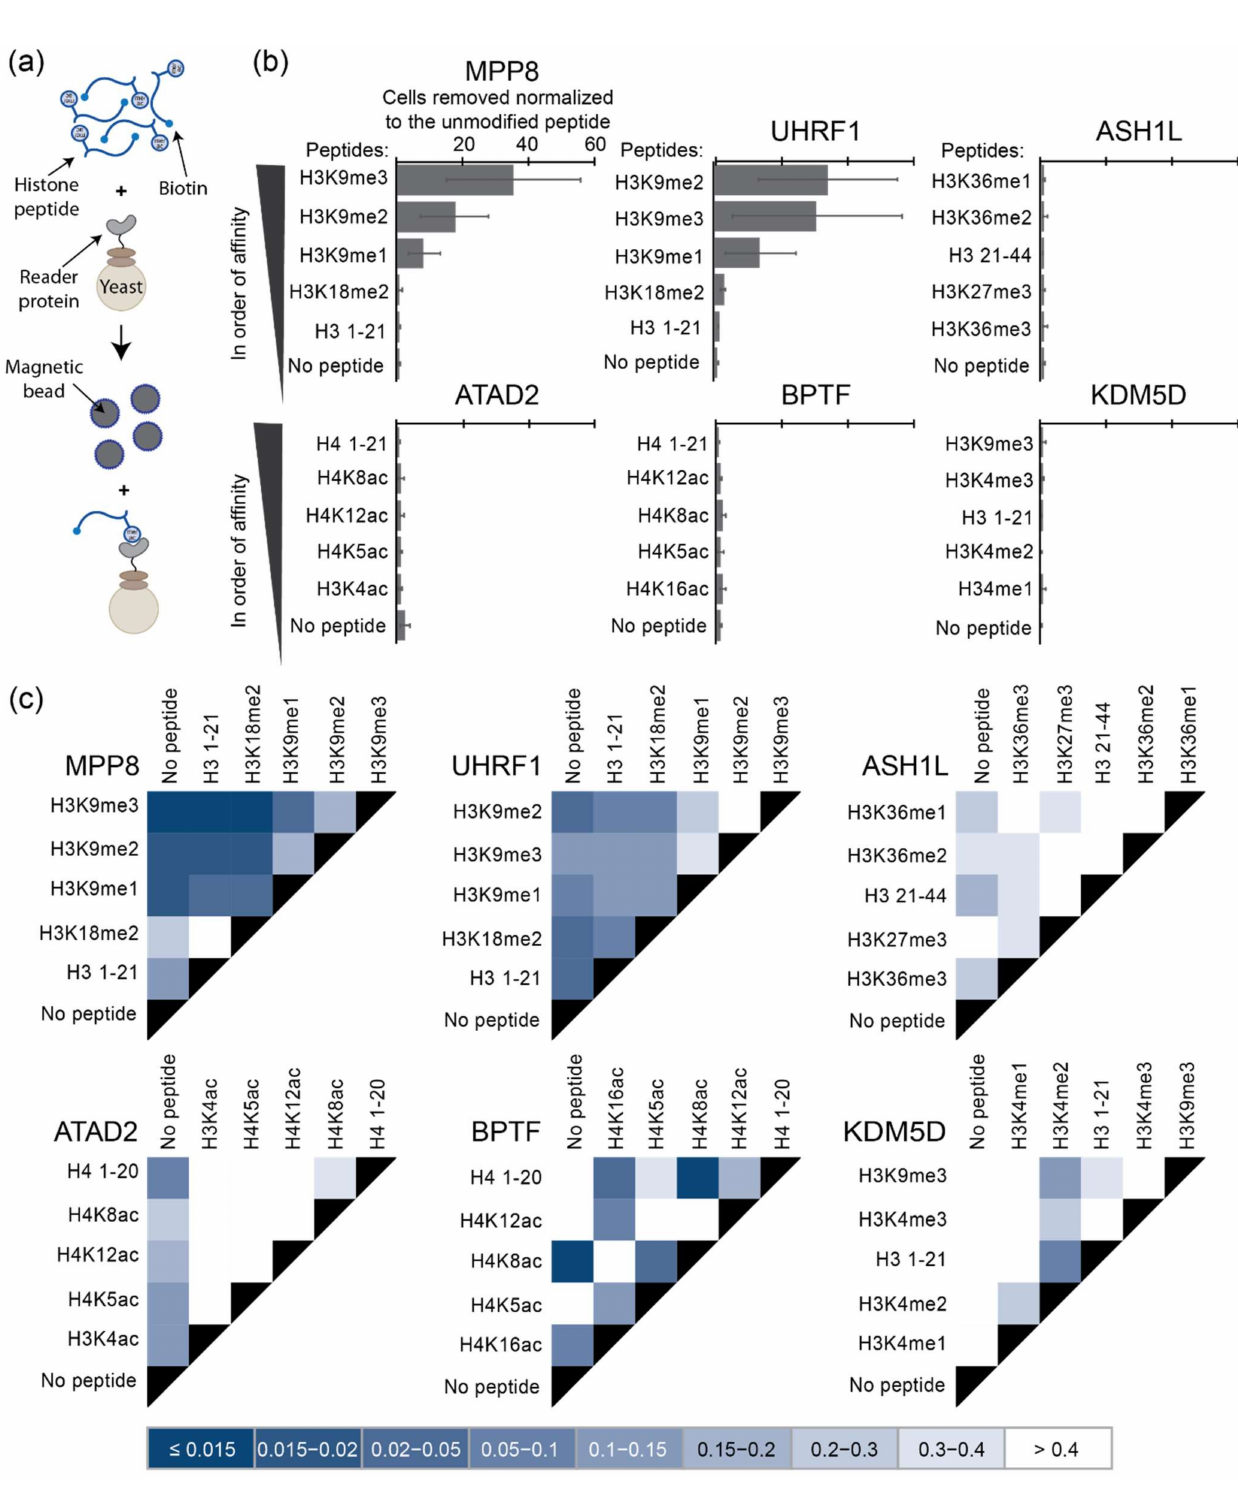
Figure 5. Soluble peptide binding followed by immobilization improves specificity. ( a ) Modi- fied “soluble MACS” method. Interaction between the freely soluble biotinylated peptide and the yeast-displaying protein is then followed by interaction between the peptide–yeast complex and streptavidin-coated magnetic beads. ( b ) Relative amounts of yeasts magnetically separated by modi- fied histones compared to an unmodified peptide control; error bars represent the standard deviation from triplicate samples; peptides displayed in order of binding affinity calculated in Figure 1 and from the literature (see Table 1). ( c ) Discrimination between the amounts of yeast separated via magnetization; darker colors are associated with a higher level of discrimination; the legend indicates p-value comparing each peptide; pairwise comparison via single-factor